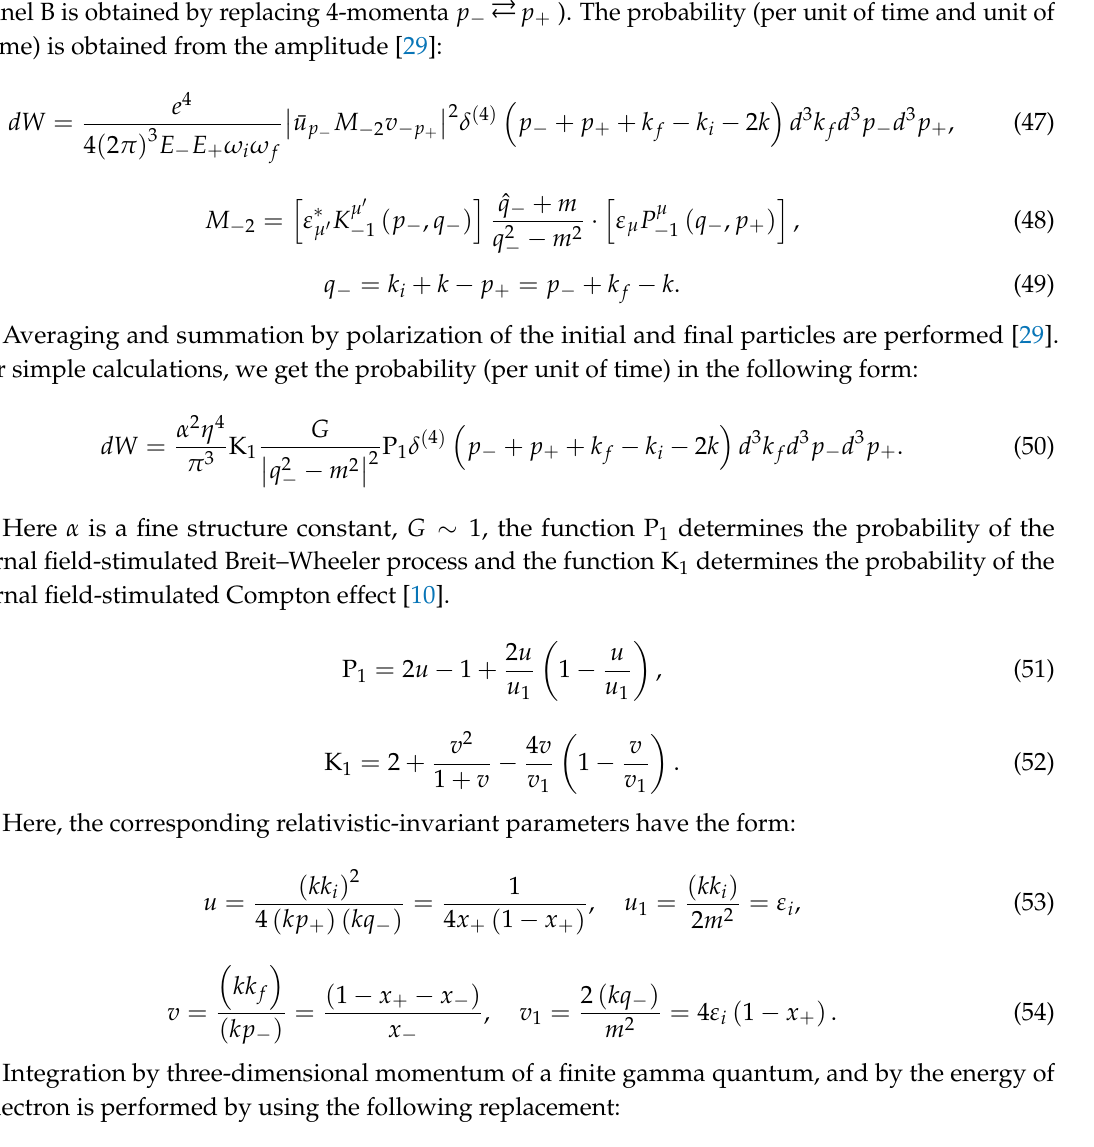
− parameter for the energy of the initial gamma quantum E = 500 MeV ( " = 5, ω = 100 MeV ) . Line i i thr